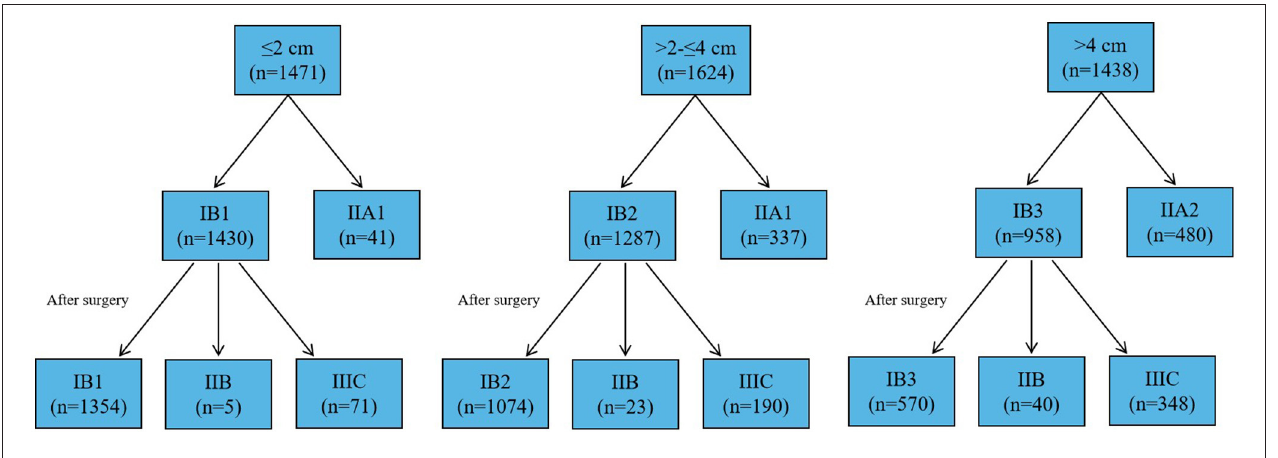
FIGURE 1 | The progression of the stage after the surgery in all the patients.